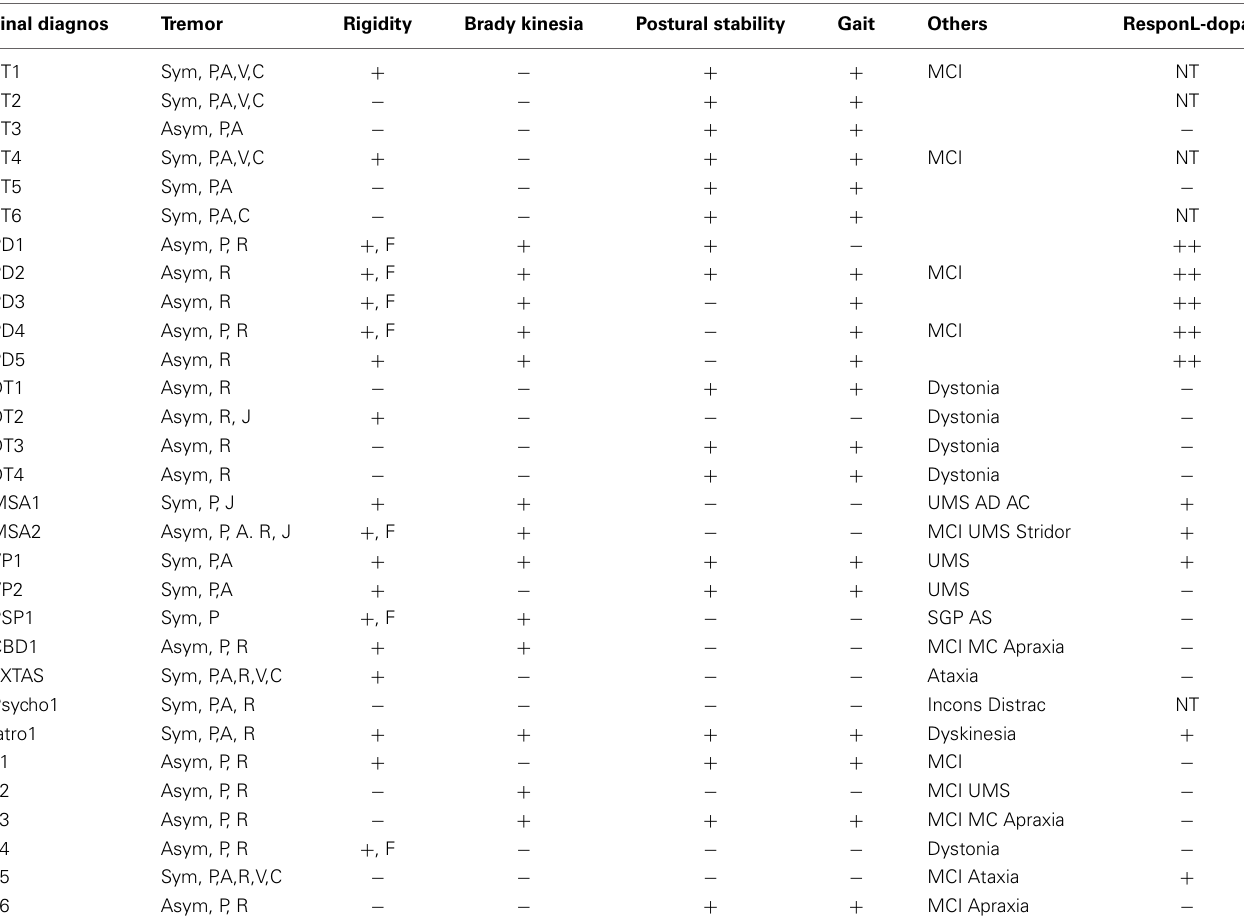
Table 2 | Main clinical features of every subject included in the study listed by final